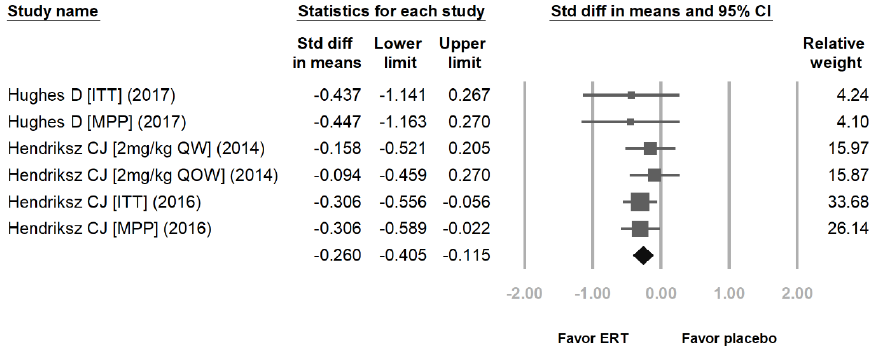
Figure 2. Proportional meta-analysis result for a pooled proportion from two cohort studies and one randomized controlled trial (RCT) for urinary keratan sulfate (uKS) in MPS IVA. The pooled proportions analysis showed that the difference in means of uKS between the enzyme replacement therapy (ERT) group and the placebo treatment group was − 0.260 [95% CI: − 0.405, − 0.115; hetero- geneity: I 2 = 0.00%, p = 0.872; overall effect: p < 0.001] (ITT: intention to treat; MPP: modified per protocol) [22,25,26]. (Reprinted/adapted with permission from Ref. [22], 2017, Hughes et al.; Ref.